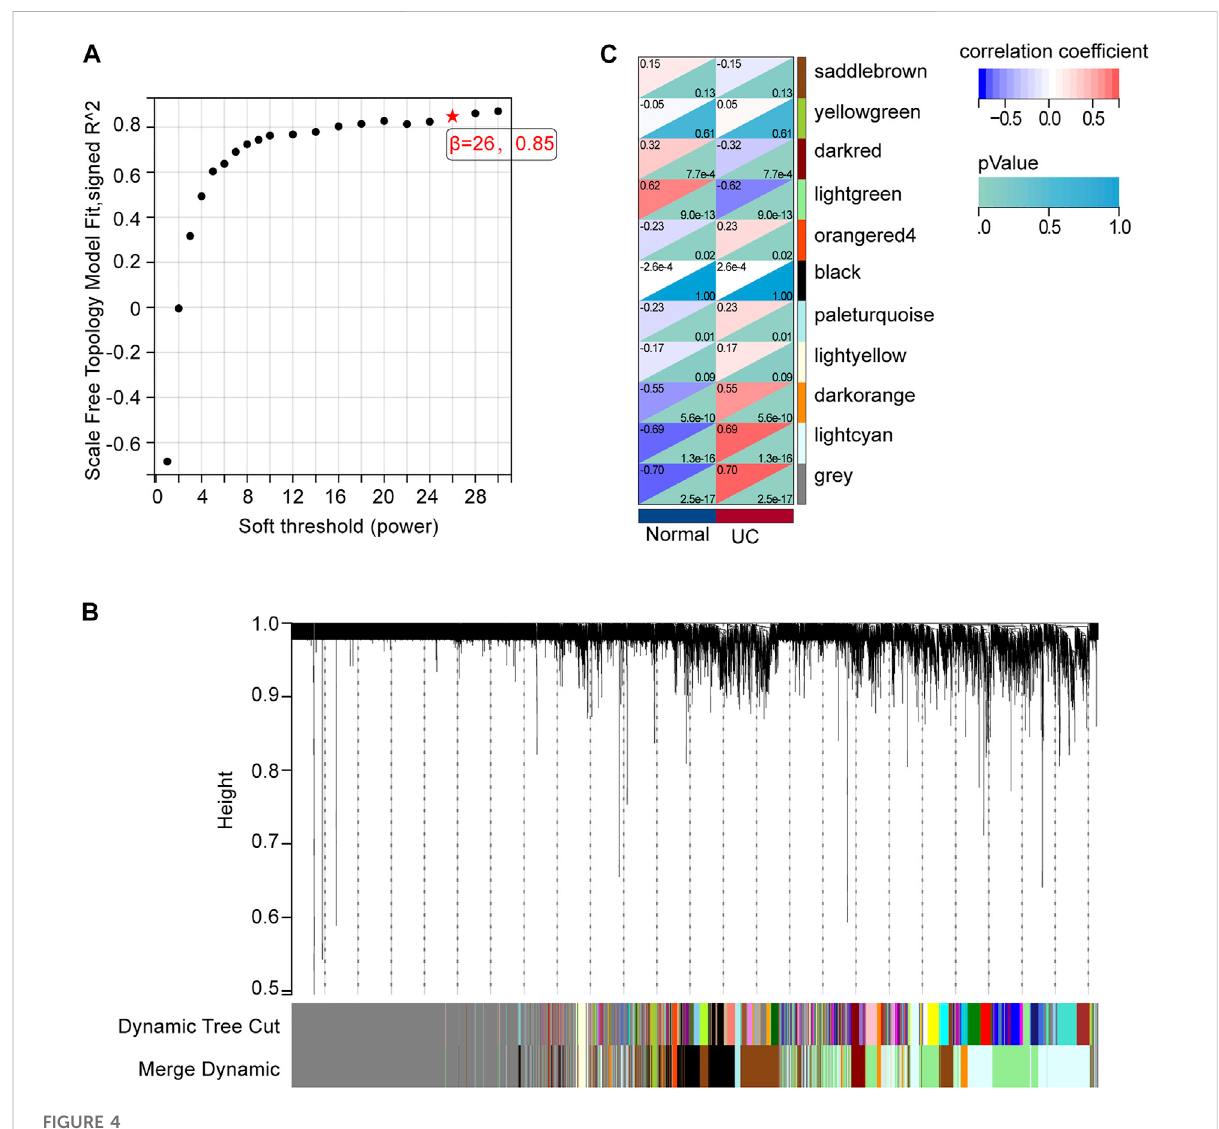
FIGURE 4 mRNA modules analyzed by WGCNA. (A) Determination of soft-thresholding power. (B) Clustering dendrogram. (C) The module-trait relationships.